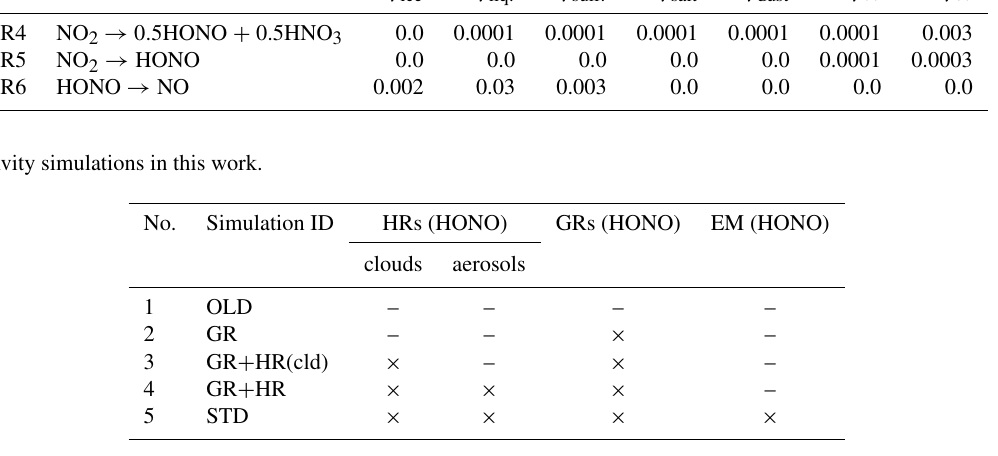
Table 2. Uptake coefficients for heterogeneous formation and loss of HONO. Reactions γ ice